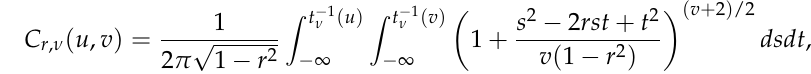
, where ( X 1 , X 2 ) follows Gaussian X 1 + X 2